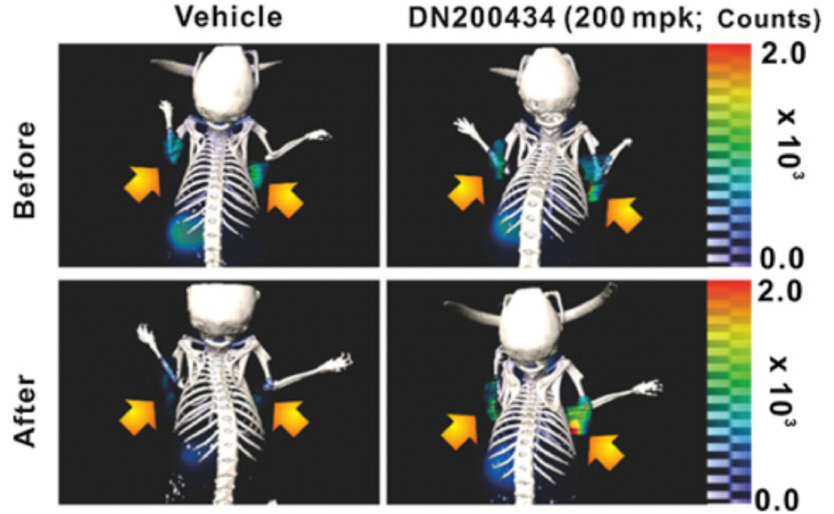
Figure 2. [ 124 I]NaI-PET/CT demonstrates enhanced iodine uptake in CAL62 ATC tumor after treatment with DN200434. The arrows indicate the ATC tumor. Reproduced with permission from [40], copyright 2019 American Association for Cancer